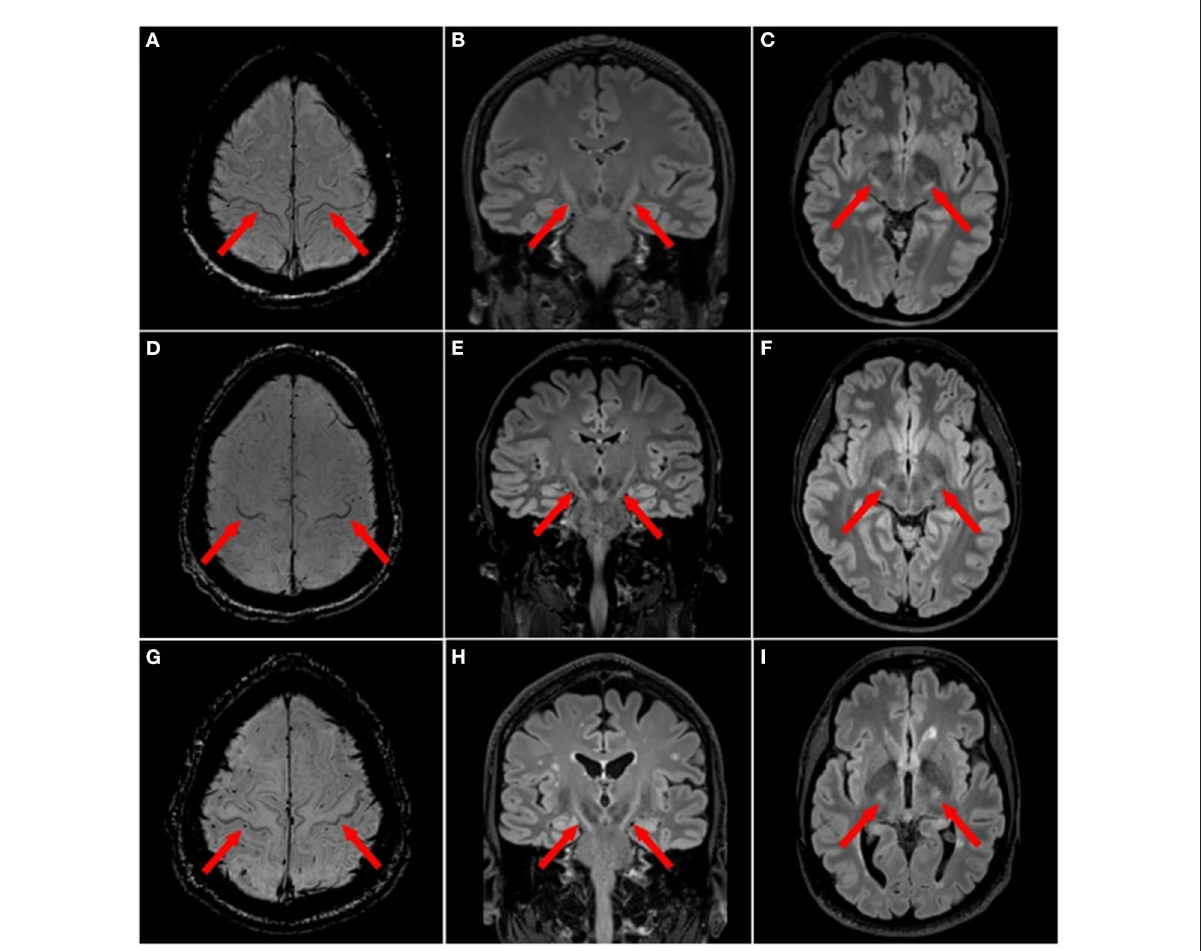
FIGURE2 Focal magnetic resonance imaging sign in motor neuron diseases. ALS patients with motor cortex hypointensities, also termed “motor band sign”, on 3T magnetic resonance imaging (MRI) with axial susceptibility weighted imaging (SWI) [ (A,D,G) red arrows] and T2 hyperintensities along the corticospinal tract (CST) on 3T 3D T2w-FLAIR in the axial [ (B,E,H) red arrows] and coronal planes (C,F,I)